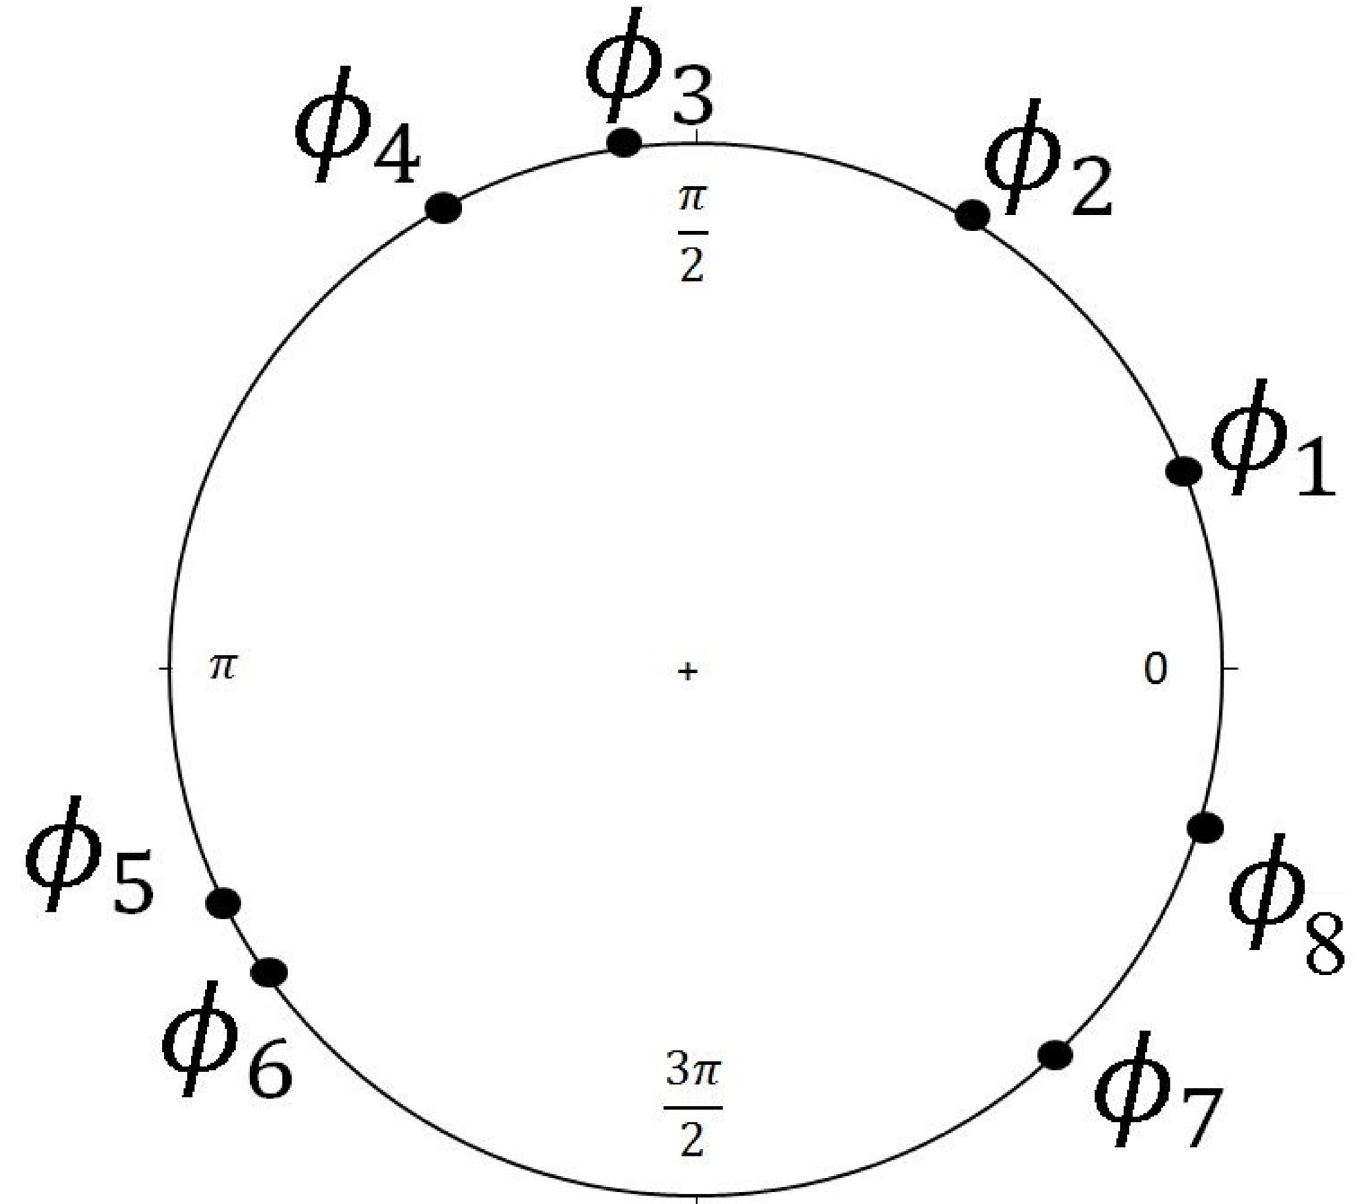
Fig 1. An illustration of the temporal order among genes g 1 , g 2 , ... , g 8 whose phase angles are in order along a circle (in counterclock-wise direction).